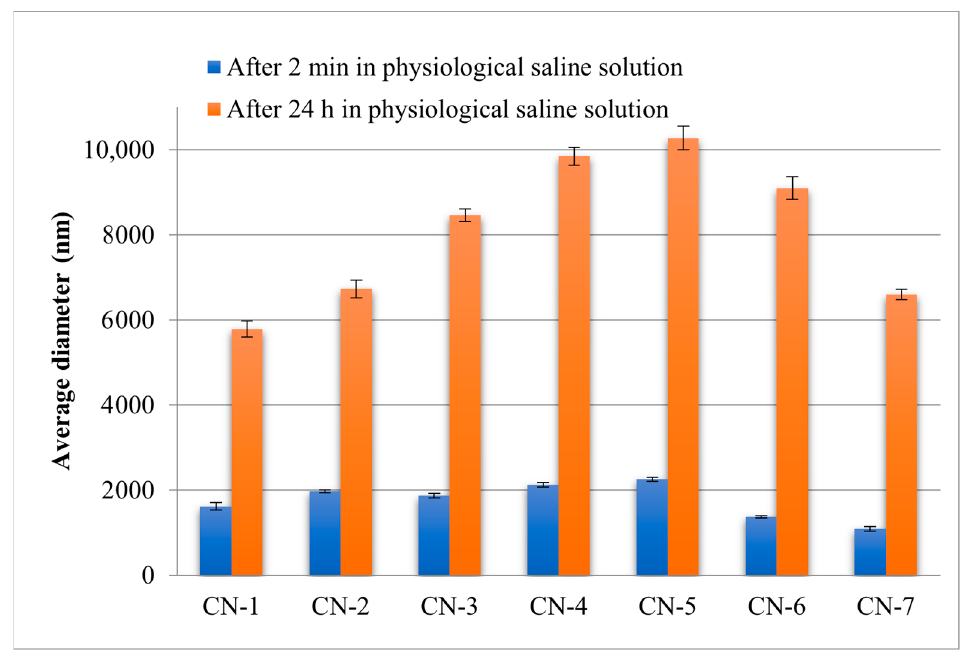
Figure 7. Evaluation of the average diameter of the NCs after 2 min and 24 h in physiological saline solutions.